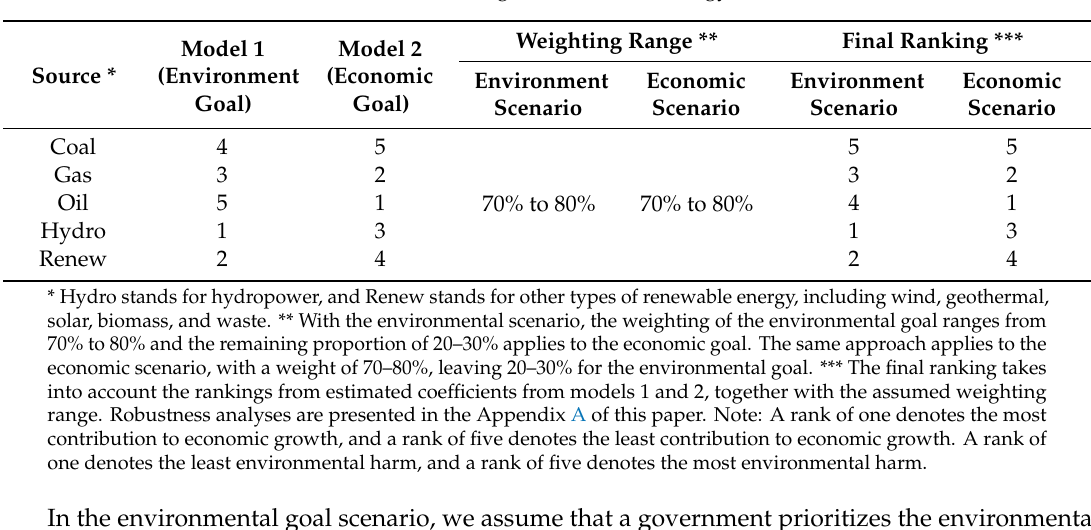
Table 10. Final ranking for each of the energy